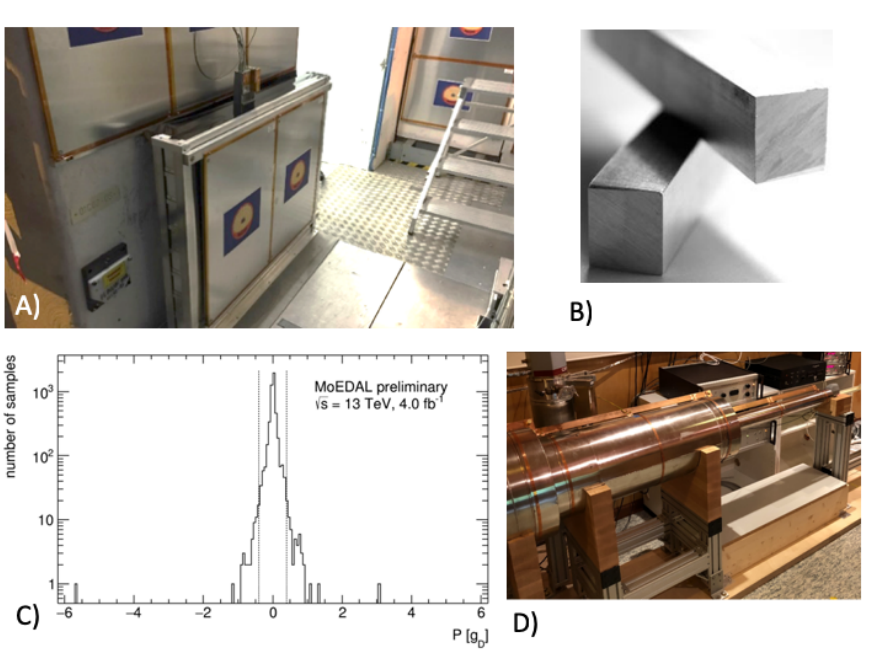
Figure 5. ( A ) The “C-side” (negative x-coordinate) MMT detector stack (with two LT-NTD detector planes attached to its front) is one of three similar arrangements; ( B ) the aluminium bars that comprise the MMT stacks; ( C ) the response of the SQUID to MMT volumes prior to exposure and presumably with no trapped magnetic charge; and ( D ) the MoEDAL SQUID facility based at ETH